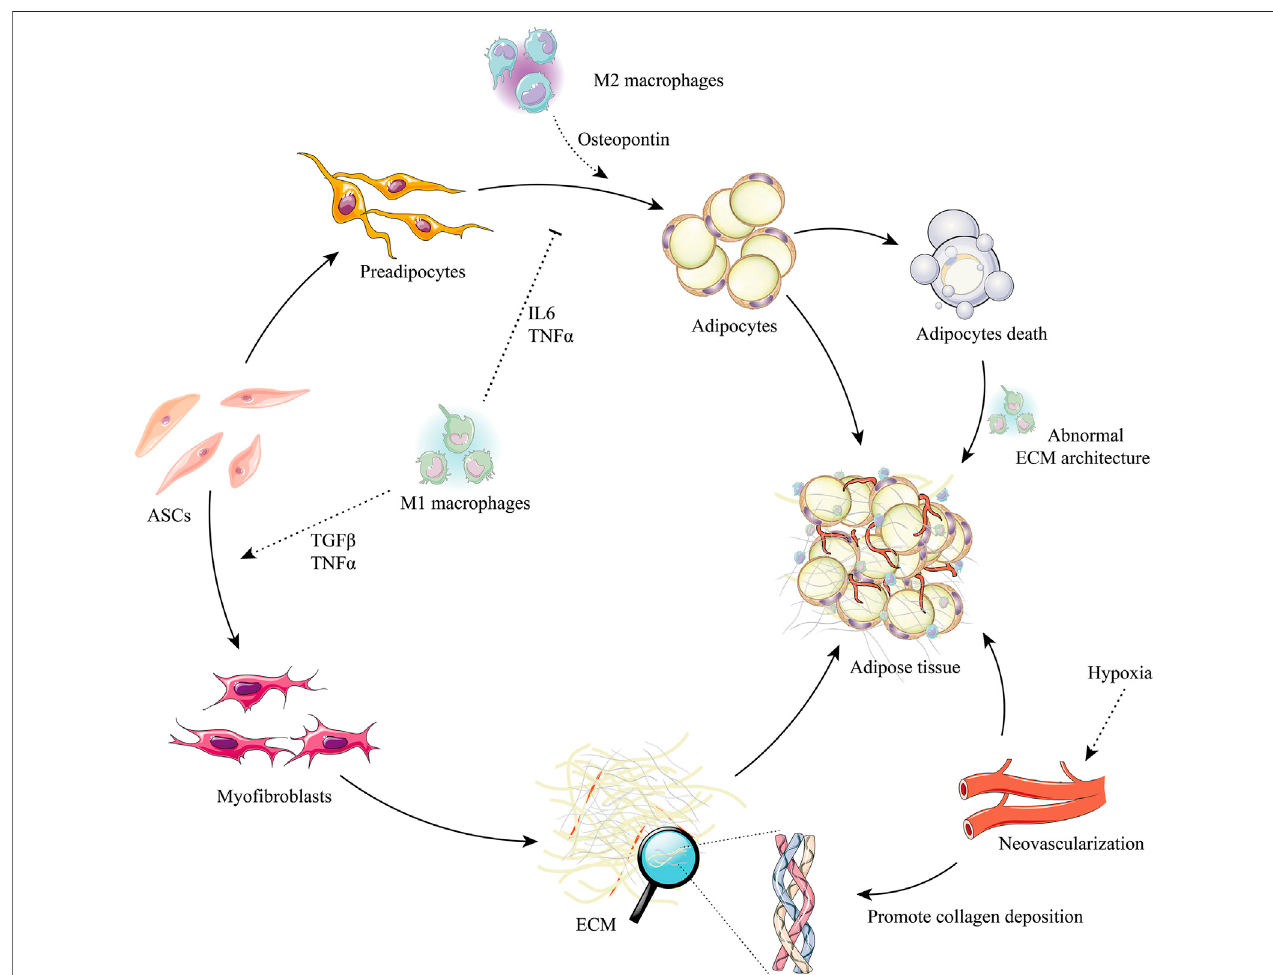
FIGURE 3 | ASCs, macrophages, and the regulation of adipose ECM remodeling after grafting. ASCs have the potential to differentiate into preadipocytes and myo fi broblasts.M2macrophagesignalspromotetheadipogenesisofpreadipocytes(e.g.,osteopontin)andaresuppressedbyM1macrophagesignals(e.g.,IL-6,TNF- α ).TheECMsynthesis potential cantriggerthemyo fi broblast phenotypeinASCs byM1macrophages signals (e.g.,TGF- β ,TNF- α ).Adipocyte deathwillrelease profuse oil droplets, which activate M1 macrophages, promote abnormal ECM deposition, and induce the formation of myo fi broblasts. Hypoxia stimulates neovascularization, which is bene fi cial to the synthesis of ECM and promotes healthy adipogenesis. Abbreviations: IL-6, interleukin-6; TGF- β , transforming growth factor-beta; TNF- α , tumor necrosis factor-alpha; M1 macrophages, classically activated macrophage; M2 macrophages, alternatively activated macrophage.